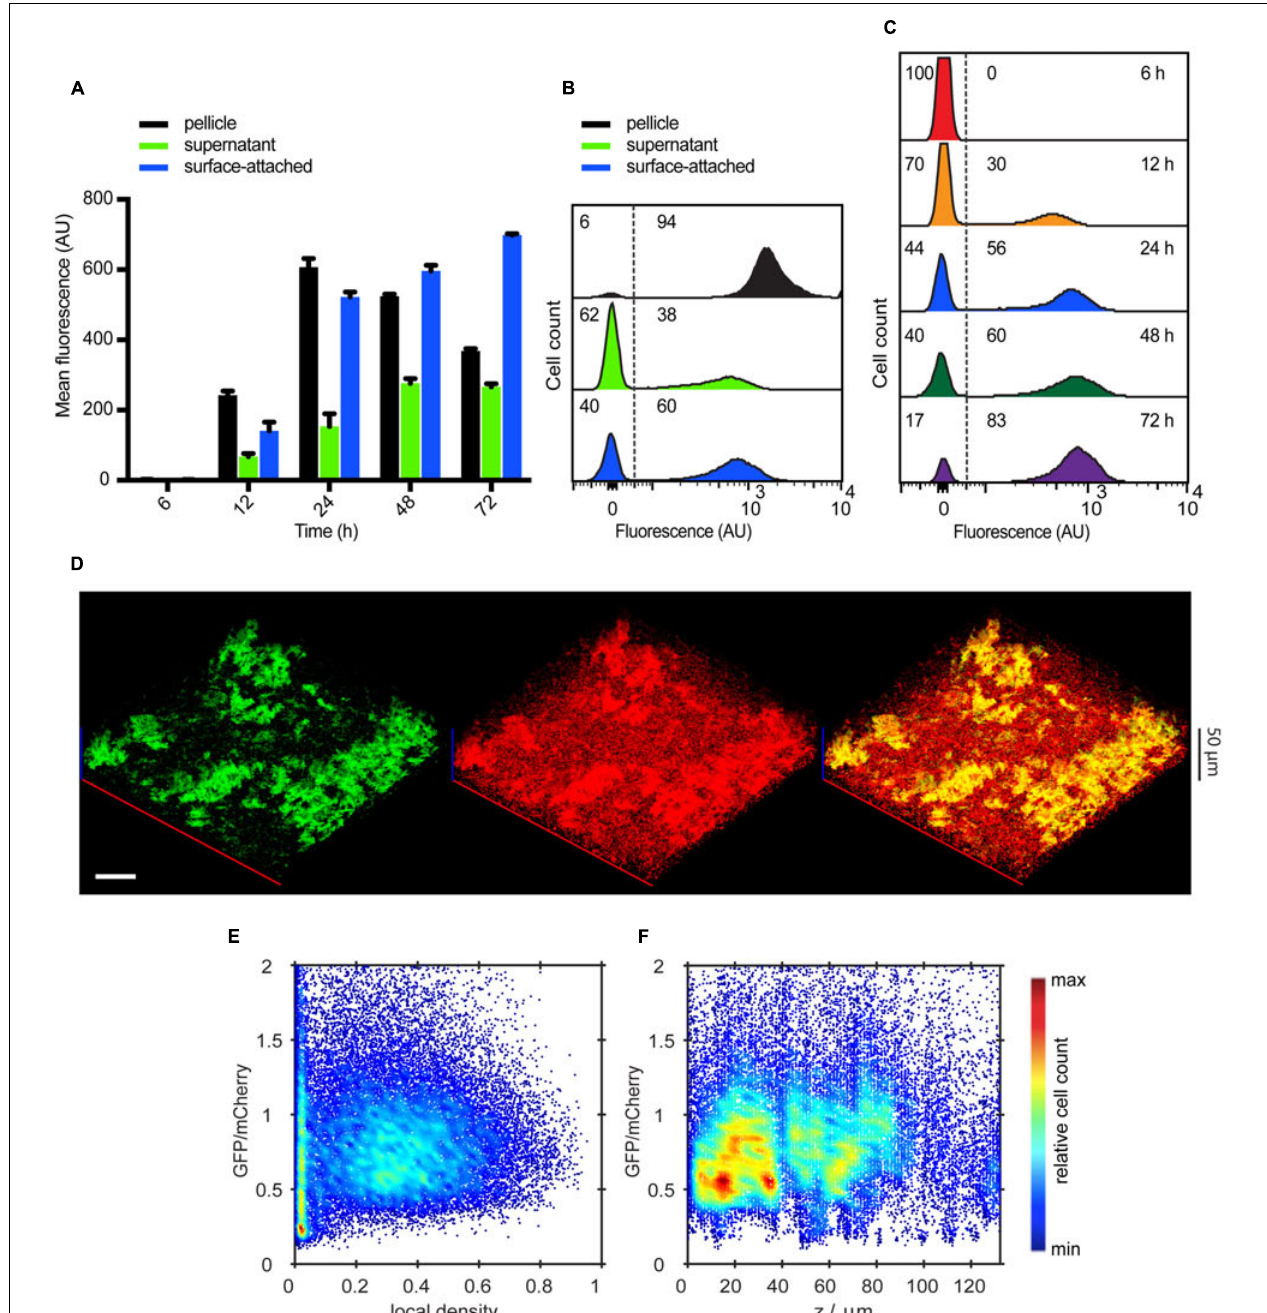
FIGURE 2 | Spatio-temporal expression of curli fibers in static submerged biofilms. (A) Mean of P csgA -sfGFP fluorescence intensity measured in fractions corresponding to pellicle, supernatant and surface-attached cells (shown in black, green and blue, respectively, as indicated) at selected time points by flow cytometry. Shown are mean values calculated from three independent experiments and corresponding standard errors. (B) Flow cytometry analysis of single-cell distributions of P csgA -sfGFP fluorescence in individual biofilm fractions at 24 h. (C) Changes in the single-cell expression of curli measured over time in surface-attached cells. Numbers in (B,C) indicate the percentage of curli-OFF and curli-ON cells (separated by dashed line). Negative values in (B,C) arise due to background subtraction (see Materials and Methods); for data visualization, biexponential transformation was applied to scale the data on the x -axis. (D) Confocal fluorescence microscopy images (maximum projection) showing expression of P csgA -sfGFP (green) in biofilms at 24 h. For a reference, all cells were labeled with constitutively expressed mCherry (red) (pOB2). Scale bar, 40 µ m. (E,F) Expression profile of P csgA -sfGFP in confocal images as shown in (D) , as a function of local density (E) and along the height ( z -axis) of the biofilm (F) . Values of GFP fluorescence are normalized to fluorescence of mCherry which labels all cells. The color scale shows relative cell count from lowest (blue) to highest (red).